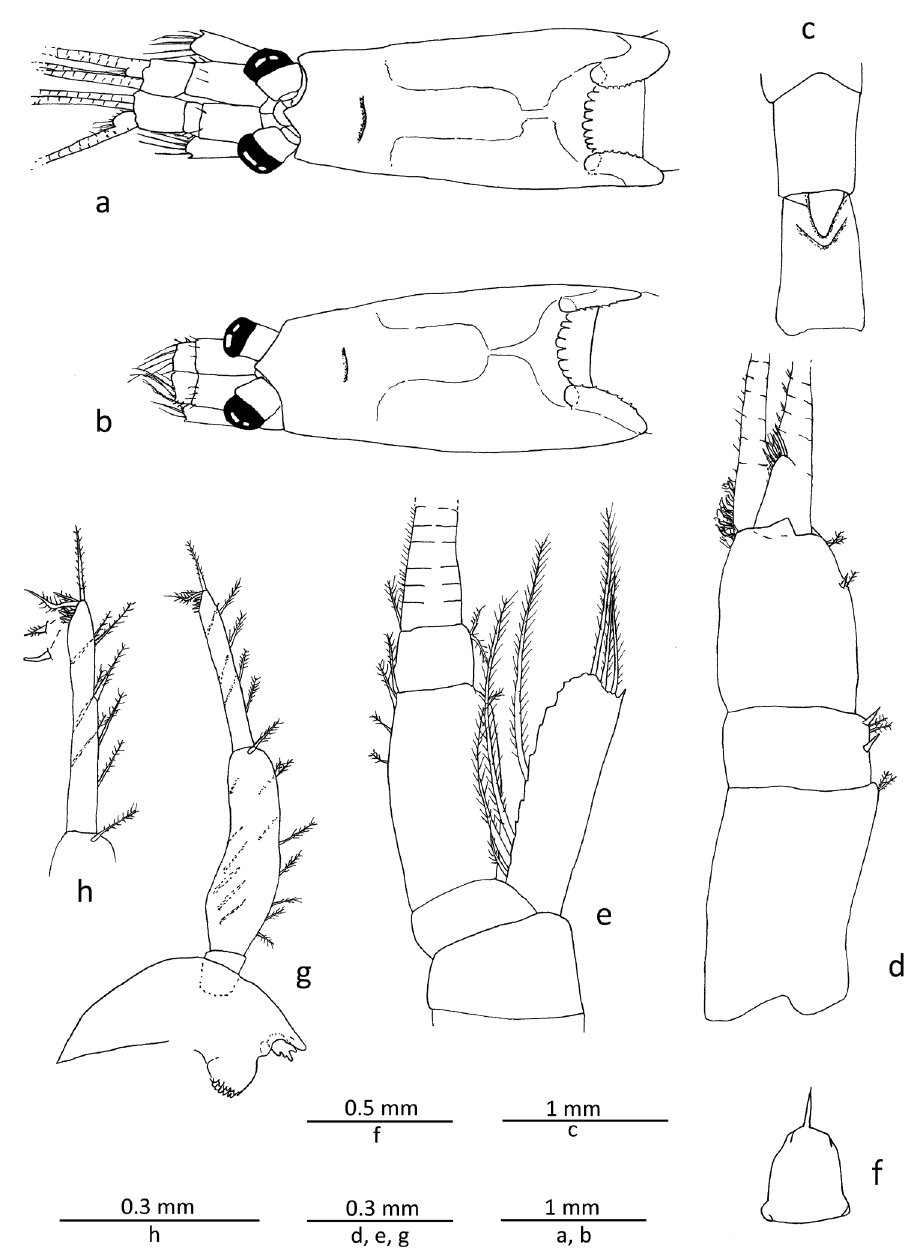
Figure 2. Gastrosaccus lombokiensis sp. n., paratype male (TL ca. 7.5 mm) ( a, c−h ) and paratype female (TL ca. 7.5 mm) ( b ): a carapace and cephalic appendages in male, dorsal view b same in female c fifth and sixth abdominal somites, dorsal view d right antennule, dorsal view e right antenna, dorsal view f labrum, ventral view g right mandible, external view h same, distal article of mandibular palp